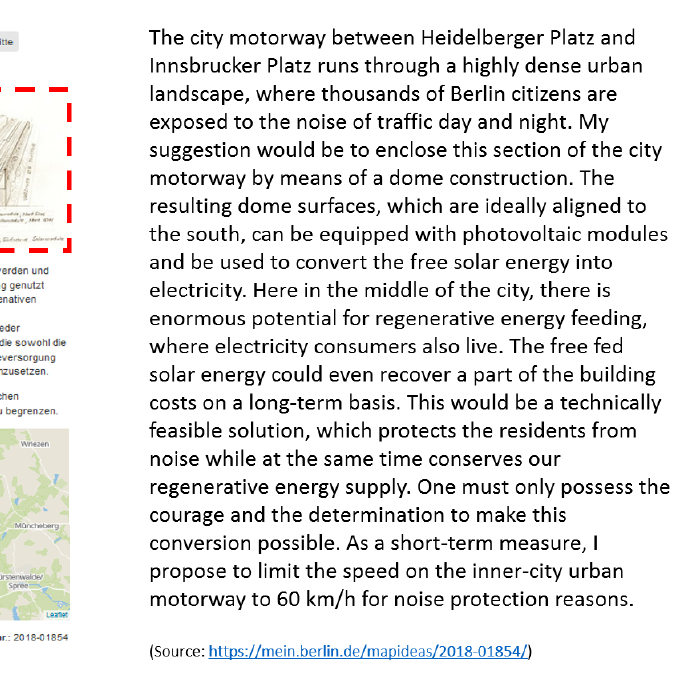
Figure 6. Roofing the motorway (authors’ own translation). Edited by the authors based on images from the ‘meinBerlin’